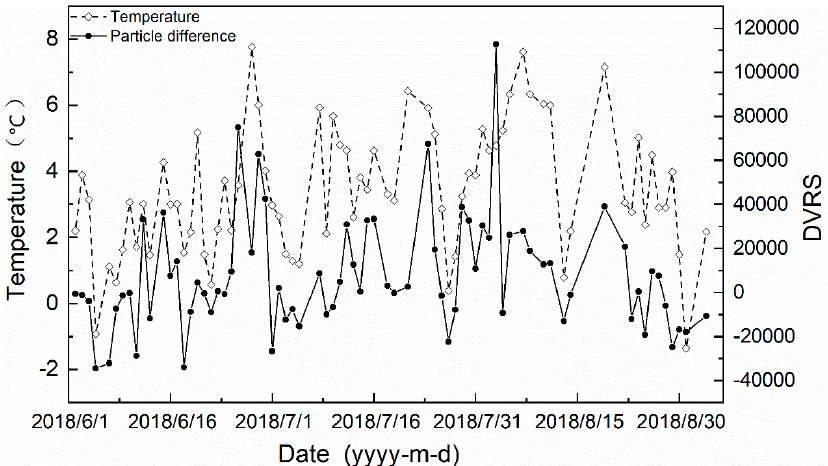
Figure 6. The di ff erence between rain and snow particles with daily mean air temperature (Ta) from June to August in 2018.